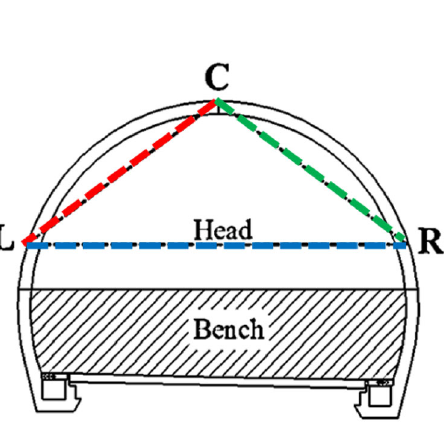
Fig. 7 Monitoring results of unstable stations in Shibli twin